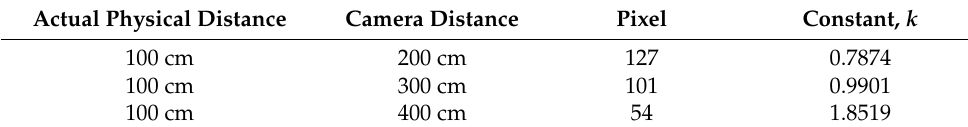
Table 9. Constant values determined at different camera distances.